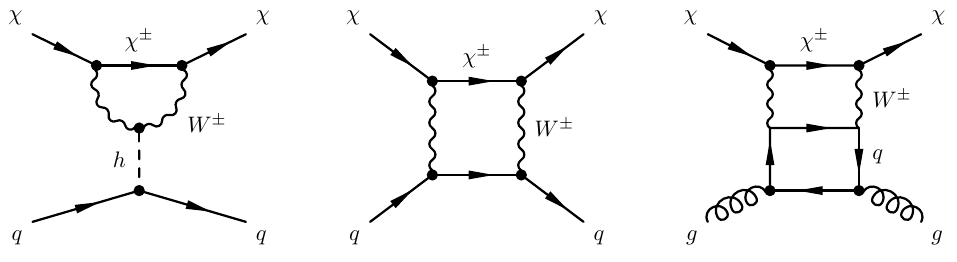
Figure 2 . Representative one-loop (left and middle) and two-loop (right) diagrams contributing to the direct detection scattering of DM that is part of an electroweak